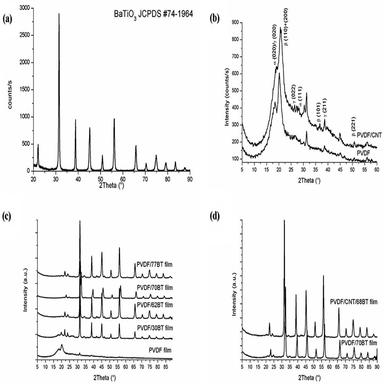
XRD patterns of: (a) barium titanate powder; (b) PVDF and PVDF/CNT films; (c) binary PVDF and BT based systems compared with neat PVDF; (d) PVDF/ 70BT and PVDF/CNT/68BT films.